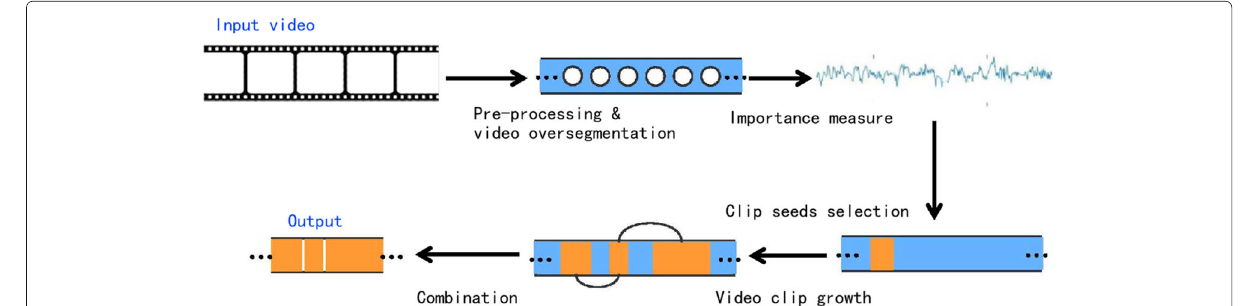
Fig. 1 Flowchart of the proposed